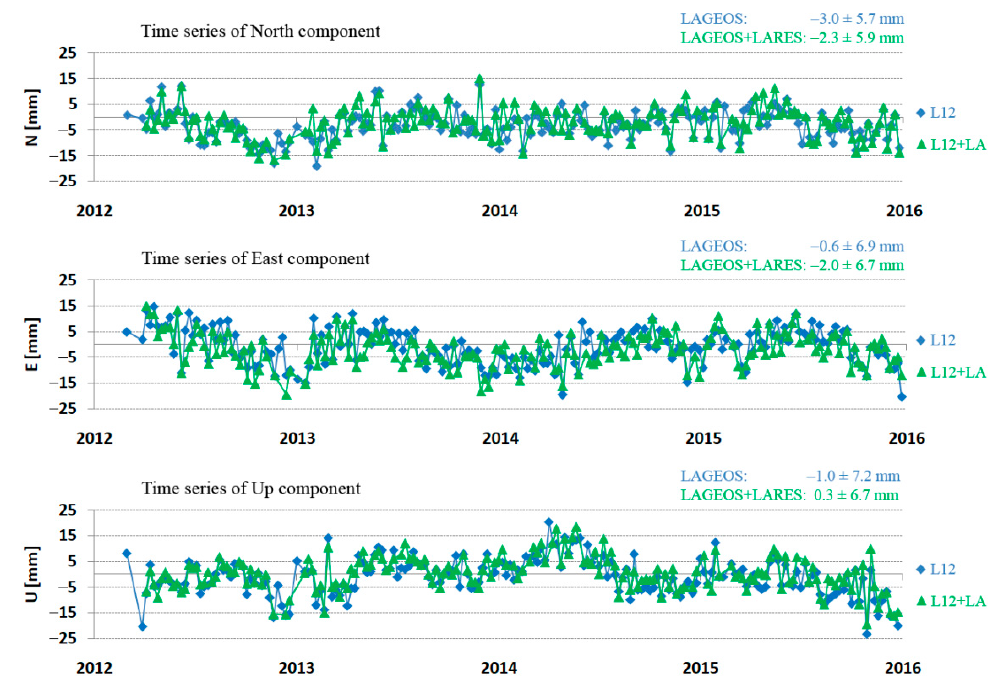
Figure 10. Time series of the North, East, and Up components for Yarragadee station (7090) for LAGEOS + LARES (green) and LAGEOS (blue) in the period from 2012 to 2015.